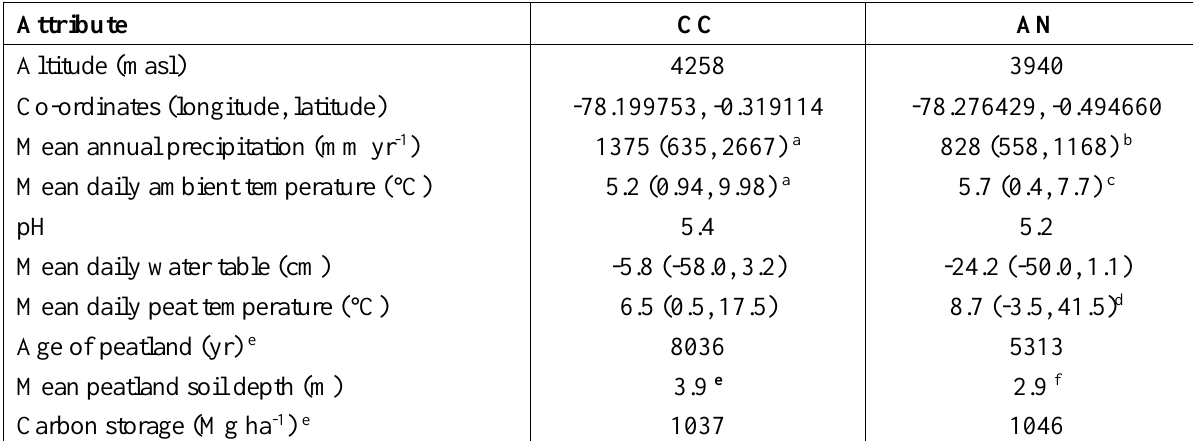
Table 1. Descriptions of the peatlands sampled at Cayambe Coca National Park (CC) and Antisana Ecological Reserve (AN). Precipitation, ambient temperature, water table level, and peat temperature are presented as mean value (minimum, maximum).